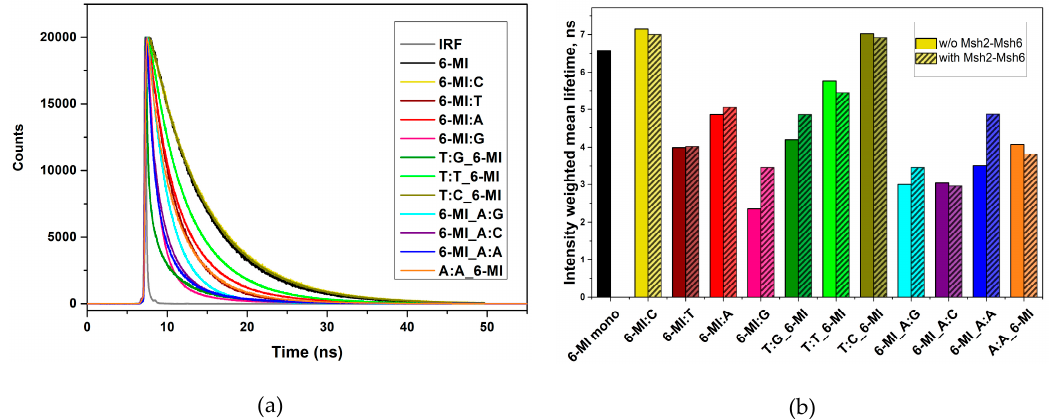
Figure 3. Base-specific investigation of mismatched base pairs using 6-MI fluorescence excited-state decay curves and intensity-weighted mean lifetimes ( a ) The instrument response function is shown in gray, and monomeric 6-MI fluorescence decay (black) is shown as a reference. The 6MI:C (yellow) and T:C_6-MI (dark yellow) duplex DNA substrates exhibit fluorescence decays similar to 6-MI monomer, indicative of significantly reduced quenching, which is further confirmed by the absence of a short-lived component (Table S4). All curves were obtained with excitation at 375 nm and emission at 460 nm. ( b ) Intensity-weighted mean lifetimes were derived from the time-resolved fluorescence decays shown in panel a. Shorter lifetimes are observed for the Msh2-Msh6 high-affinity substrates; which exhibit the same or longer mean lifetimes upon protein binding. 6-MI monomer is shown as a reference (black).